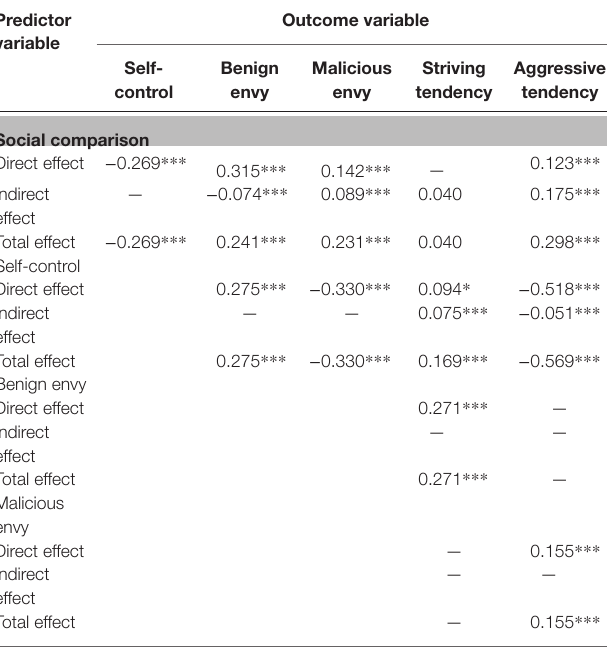
TABLE 2 | Dissociation of the influencing factors of envy and self-control (standardized parameters). Predictor